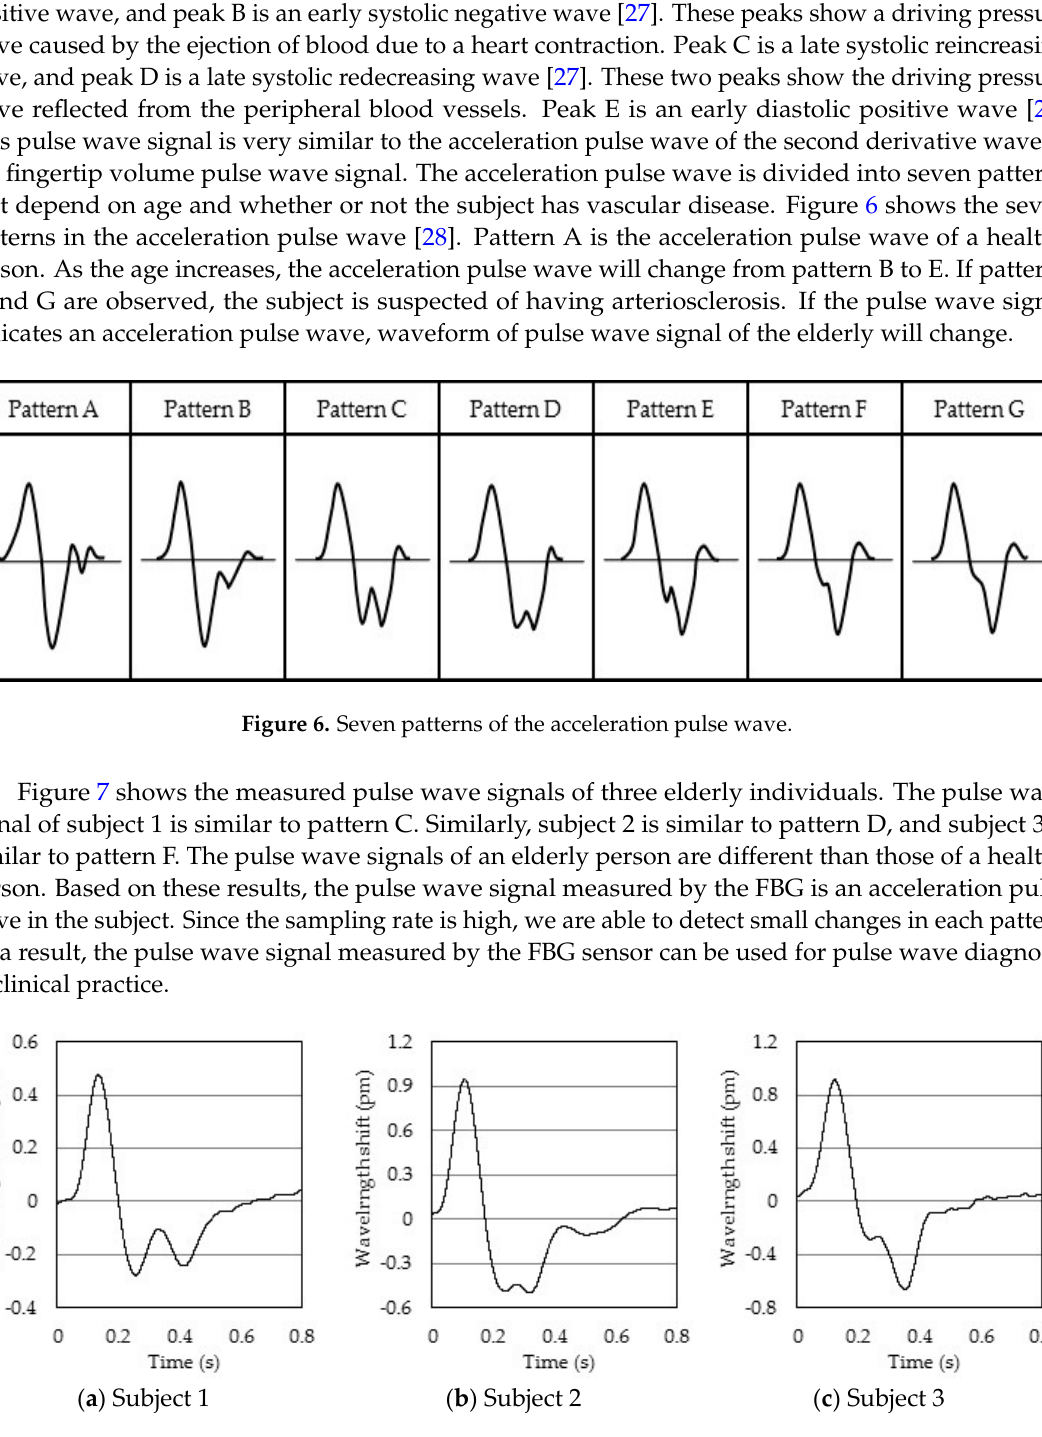
Figure 7. The measured pulse wave signals of three elderly persons: ( a ) Subject 1; ( b ) Subject 2; ( c ) Subject 3.